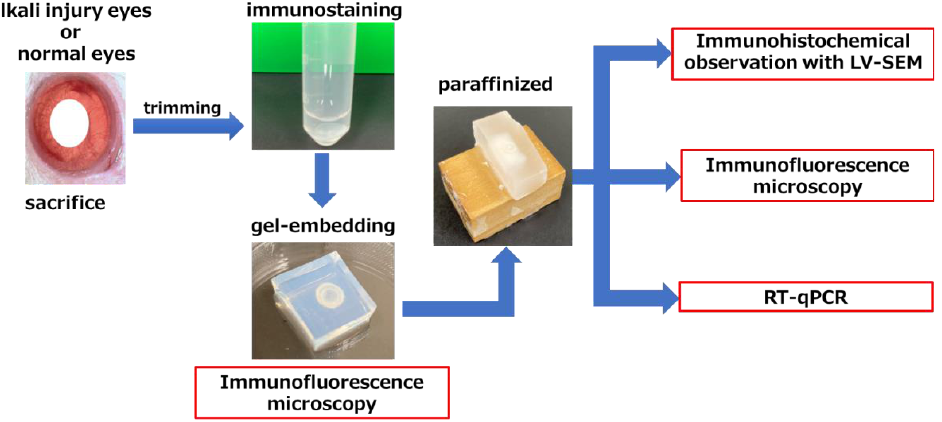
Figure 7. Schematic representation of a multiple-observation model of a single specimen. Each group contained four specimens. At each endpoint, the eyes were fixed after sacrificing the rats and trimmed to retrieve the anterior eye only. Zinn’s zonule was fluorescently stained with MAGP1, a component of Zinn’s zonule, and embedded in a gel. After initial observations, the gelatin in these sections was replaced with paraffin, and 5 μm sections were made for LV-SEM and fluorescent staining. LV-SEM, low-vacuum scanning electron microscopy; RT-qPCR, reverse transcription quantitative polymerase chain reaction.